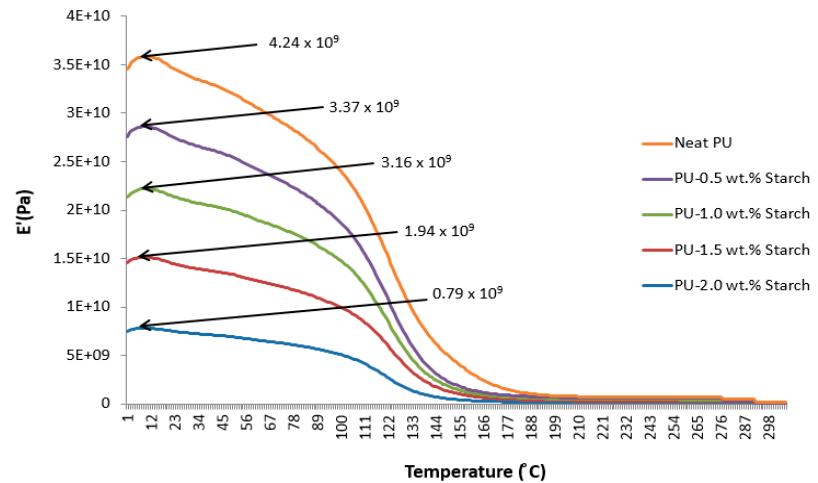
Figure 7. Storage modulus of PU and PUS composites.